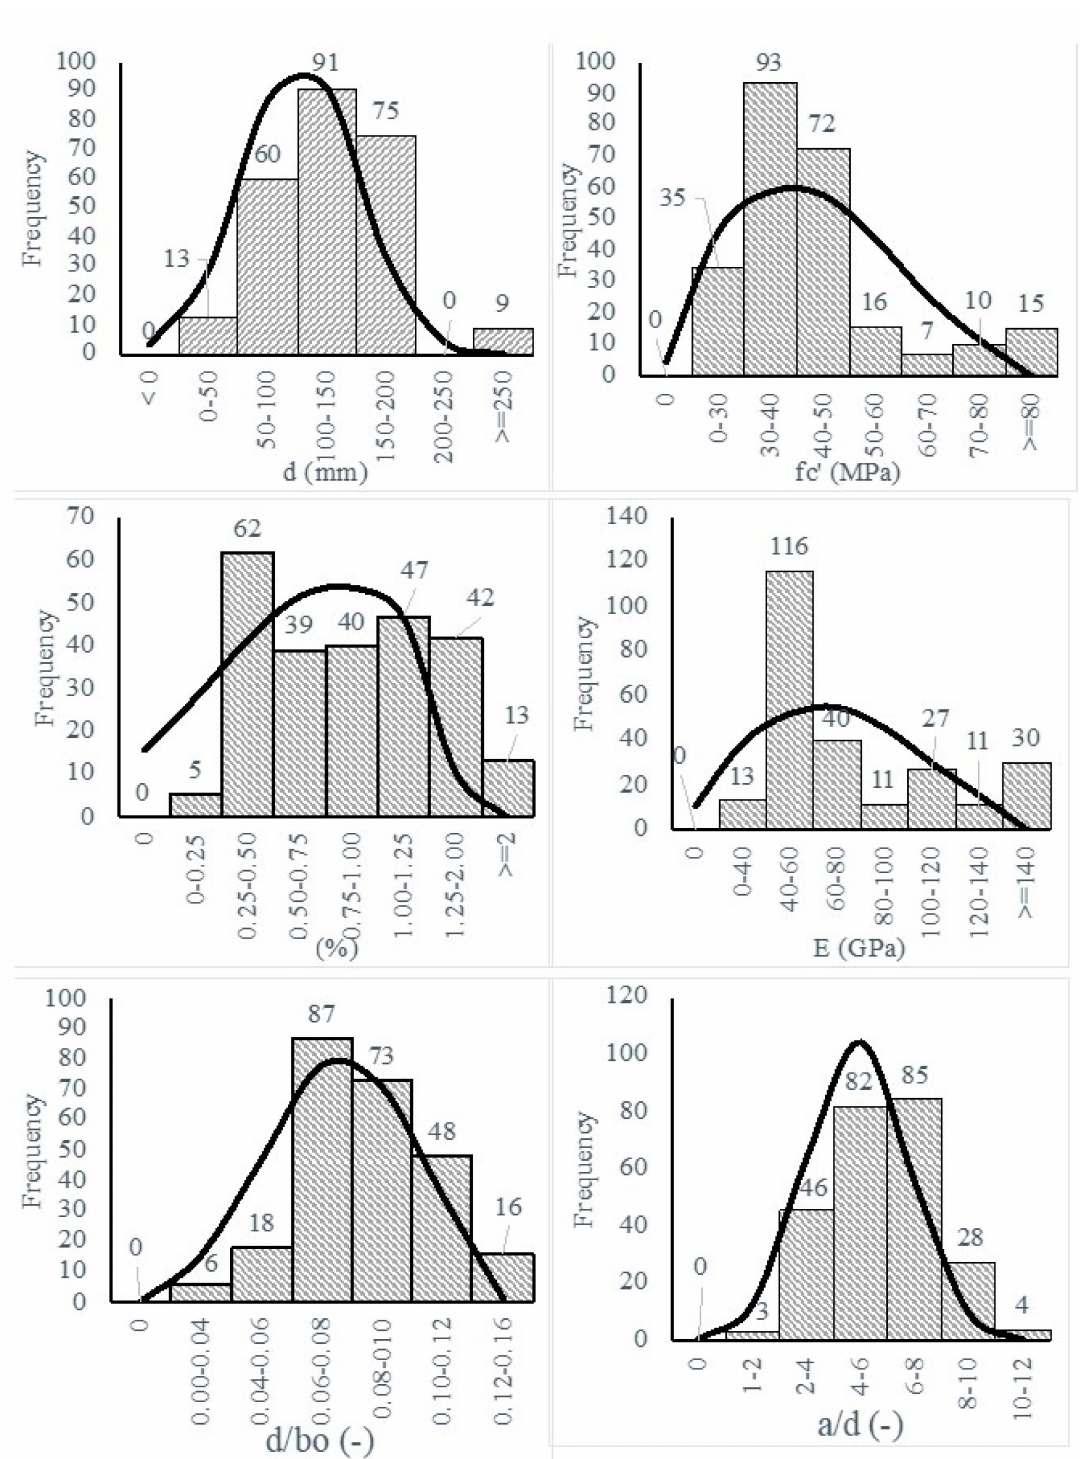
Figure 3. Frequencies and ranges of the tested column-slab connections with